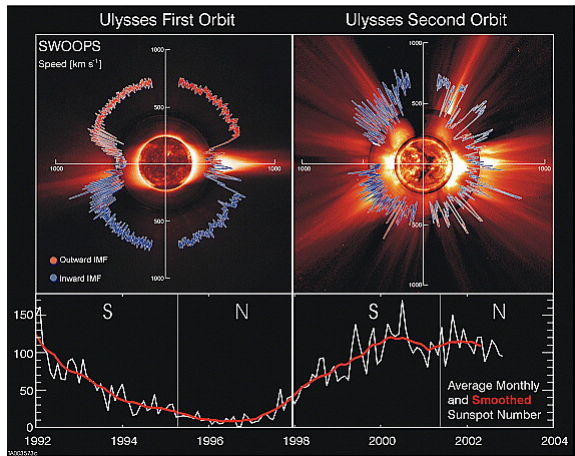
Figure 51: Large scale solar wind profile as a function of latitude during minimum (left panel) and maximum (right panel) solar cycle phases. The sunspot number is also shown at the bottom panels. Image reproduced by permission from McComas et al. (2003), copyright by